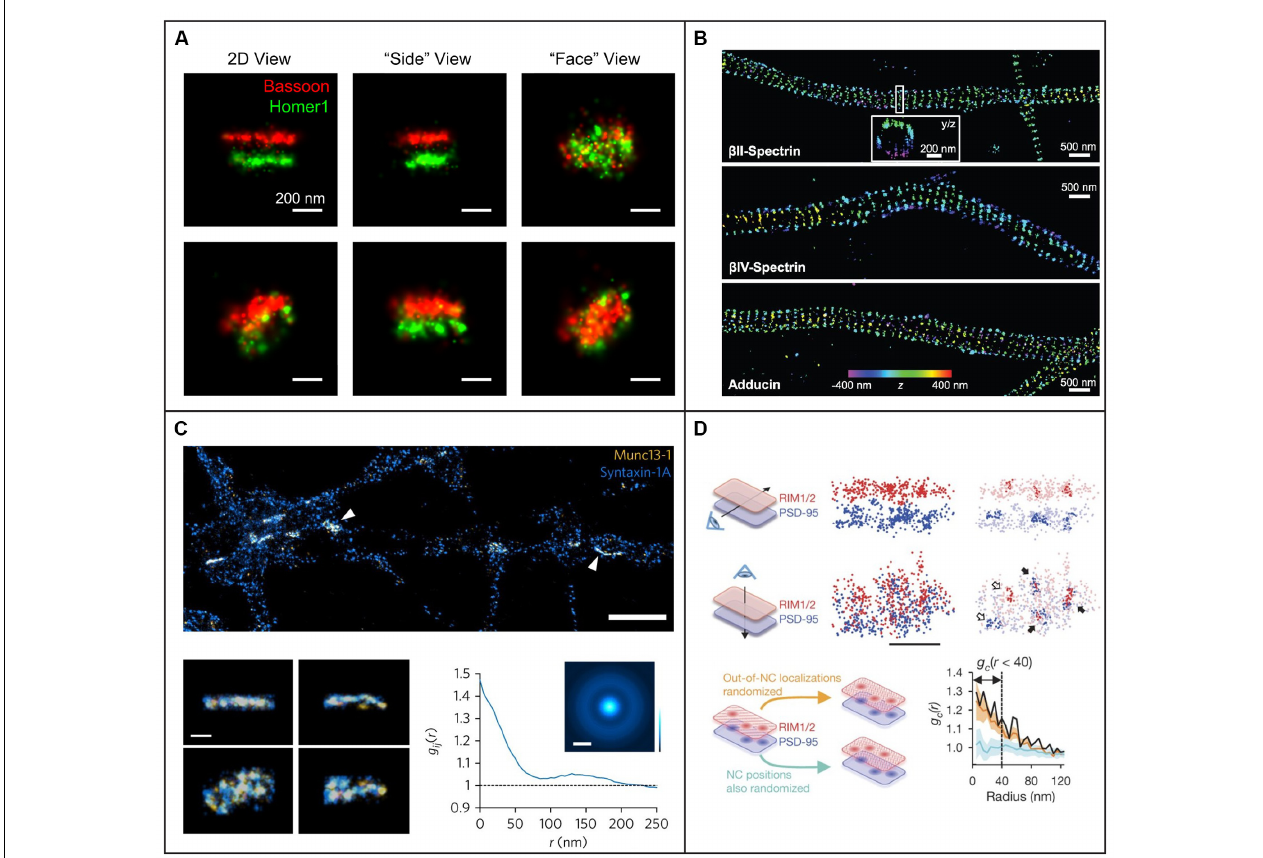
FIGURE 5 | Examples of 3D single-molecule super-resolution imaging in neurons and synapses. (A) STORM with astigmatism was used to image pre- and postsynaptic scaffolding proteins Bassoon and Homer1 in 3D, providing information about the shape of the presynaptic active zone and postsynaptic density from different angles for two different pre- and postsynaptic pairs in the top and bottom row, respectively. The scale bars are 200 nm. Figure reprinted with permission from Dani et al. (2010). (B) STORM with astigmatism was used to image and analyze the 3D organization of cytoskeletal protein spectrin and actin-capping protein adducin, revealing their periodic axon-surrounding structure. The scale bars are 500 nm. Figure reprinted from Xu et al. (2013). Reprinted with permission from AAAS. (C) STORM with astigmatism was used to image multiple views of Munc13-1 (yellow) assemblies and syntaxin-1A (blue) at the active zone. The graph illustrates pair correlation analysis of the STORM datasets, demonstrating nanoscale co-clustering of Munc13-1 and syntaxin-1A. The scale bar is 2 µ m in the top panel and 200 nm in the bottom panel. Reprinted by permission from Springer Nature: Springer Nature, Nature Neuroscience, (Sakamoto et al., 2018), copyright 2018. Reprinted with kind permission from Springer. (D) Light sheet illumination combined with two-color 3D-STORM was used for imaging of synaptic RIM1/2 and PSD-95. The trans-synaptic alignment of protein nanoclusters in the active zone and the PSD are shown both with top and side views. Closed arrows indicate the trans-synaptic alignment and open arrows correspond to non-aligned nanoclusters. In the lower panels a paired cross-correlation function is shown for RIM1/2 and PSD-95 distributions in two different simulated conditions: first, for randomly distributed nanoclusters (light blue trend), and second, for a random selection of molecules outside the originally measured nanocluster positions (orange trend). The scale bar is 200 nm. Reprinted by permission from Springer Nature: Springer Nature, Nature, (Tang et al., 2016), copyright